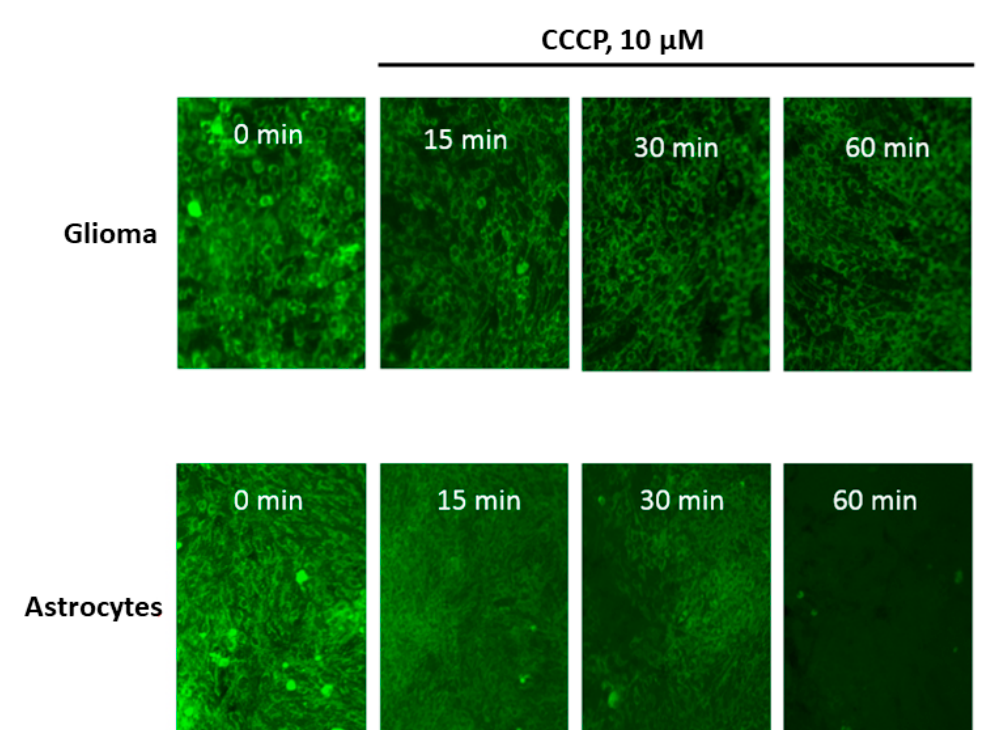
Figure 1. The time-dependent loss of fluorescence of Rh123 caused by the uncoupler in cells attached to the substrate (glioma C6, upper row and astrocytes, lower row). The cells were incubated for 2 h with Rh123 (2 µM), after which they were placed in a rhodamine-free medium containing 10 µM of CCCP, and fluorescence was recorded in time intervals (15, 30, and 60 min) using conventional fluorescent microscopy. Before taking the picture, at each time, we placed the cells in a rhodamine-free culture medium. The images represent the near monolayer state of cell cultures with approximately 200 cells in the field of view.